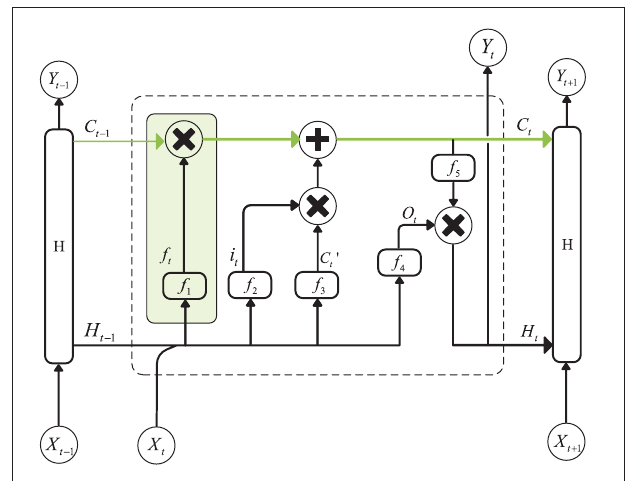
FIGURE 1 | Structure of Long Short-Term Memory. The green line above the graph represents the cell state. The green box represents the gate, which controls the updating of the cell